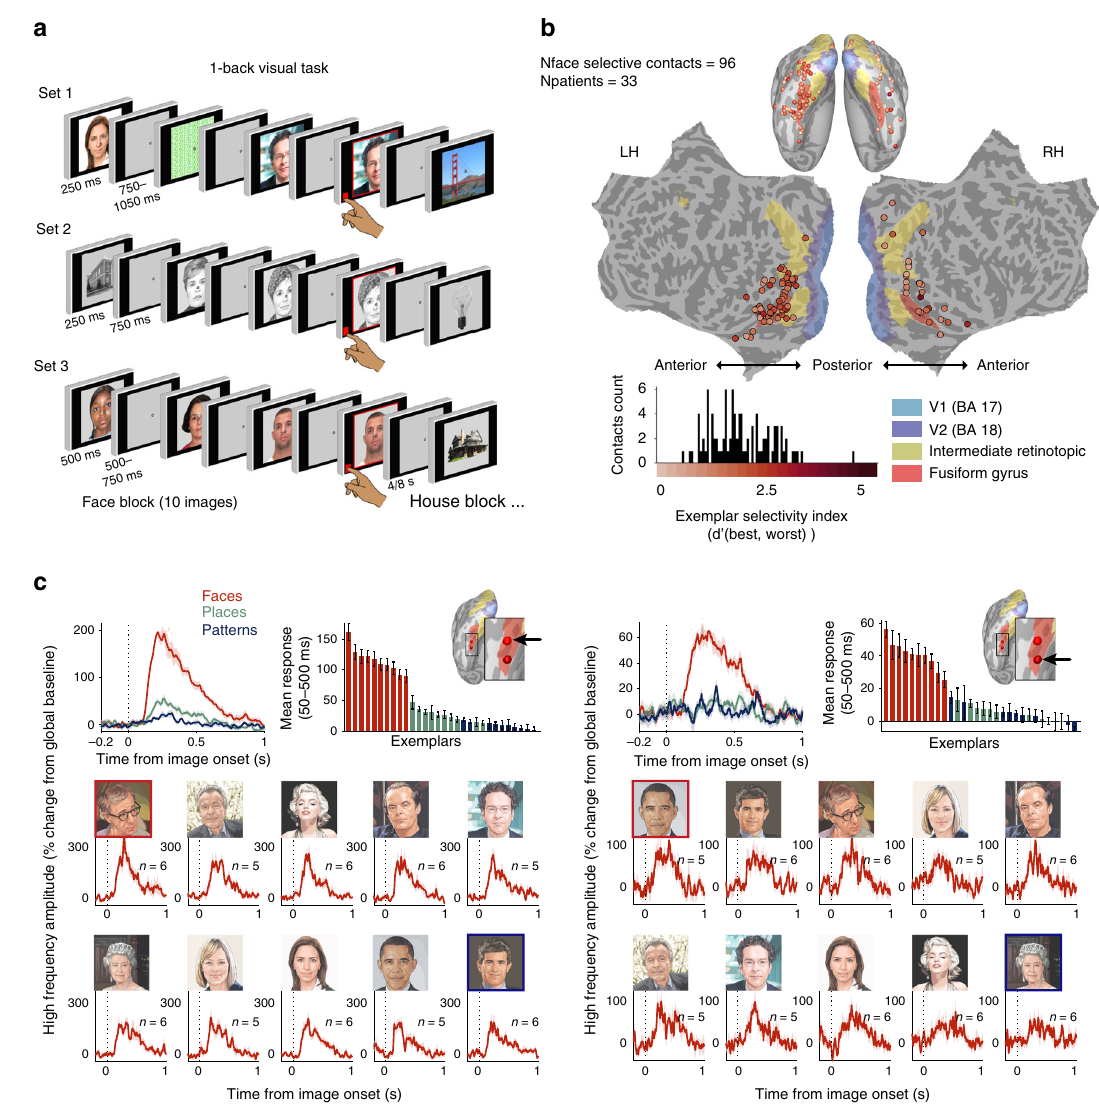
Fig. 1 Experimental design, localization and exemplar selectivity of face selective iEEG contacts. a Schematic illustration of the 1-back visual tasks. Three versions, each including a different set of face stimuli and additional images from other categories, were included in the study. Every patient took part in either one or two versions out of the three. Faces used in set 3 (examples shown here) were taken from the face database by Minear and Park 56 . b Anatomical distribution of detected face contacts, projected onto a common template of the in fl ated (ventral view, top) and fl attened cortex. Color coding denotes exemplar selectivity indices, de fi ned as the d ′ between the most- and the least-preferred face exemplars. Histogram presents the distribution of selectivity indices alongside the color code bar. The same distribution is presented separately for each of the three sets in Supplementary Fig. 1. c Example of two neighboring face contacts implanted in the same patient, their anatomical locations marked by black arrows on the in fl ated left hemisphere. Top left panel depicts the mean HFA response across face, place, and pattern exemplars in set 1, demonstrating robust face selectivity. Top right bar plot depicts the mean HFA response (50 – 500 ms) to each of the exemplars in a descending order of activation, with bar colors denoting visual category. Bottom galleries present the mean HFA response of each contact to the different faces with the corresponding images. Galleries are presented in a descending order of mean response (as in the bar plots). HFA was normalized to % signal change from global baseline at − 200 to 0 ms. All error bars denote s.e.m. Note the differences in response amplitude to different exemplars which was unique to each iEEG contact. Faces shown for sets 1 and 2 in all fi gures are accurate illustrations of the original images used, in compliance with copy rights limitations. Exceptions are Fig. 4 and Supplementary Fig. 12, in which original images of most exemplars in set 1 are